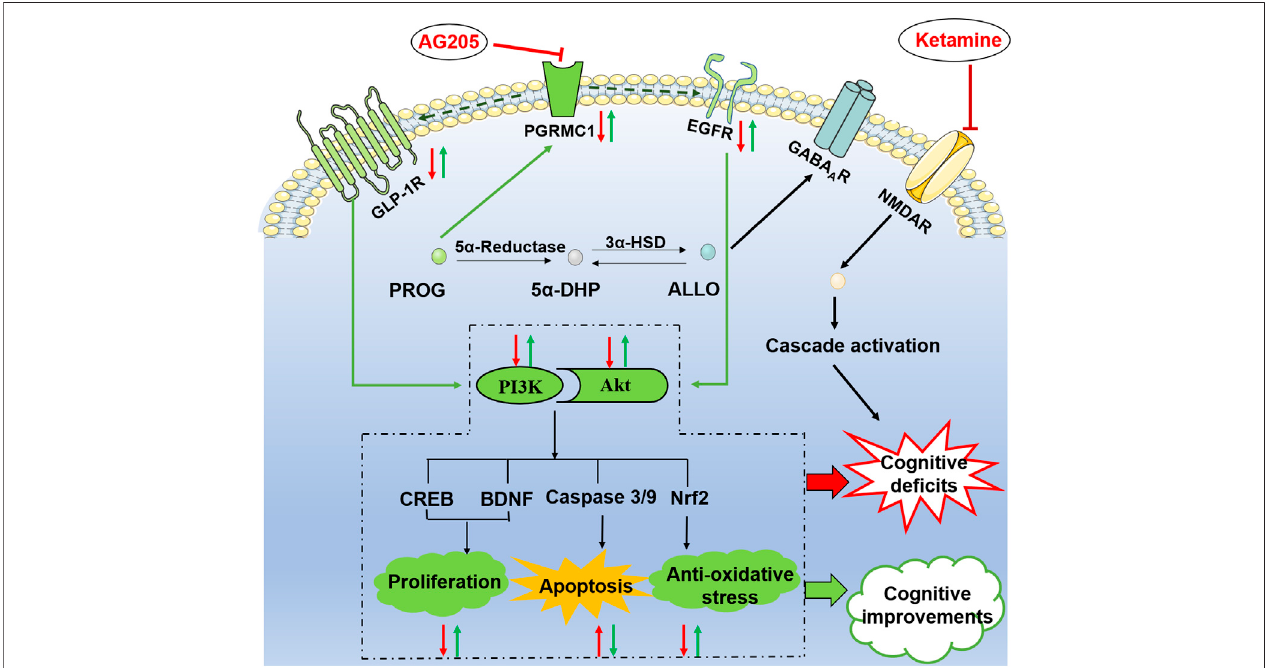
FIGURE 6 | Illustrative model of the mechanism underlying the neuroprotective effects of PROG and ALLO against ketamine-induced cognitive de fi cits. Under certain conditions, the PI3K/Akt pathway can be activated to exert its neuroprotective function by phosphorylating a battery of protein substrates, including Nuclear factor erythroid-2-relatedfactor 2(Nrf2), caspase-3/9,cAMPresponse element-binding protein (CREB) and brain-derived neurotrophicfactor (BDNF). Furthermore, the PI3K/Aktpathway isaputativedownstreamsignalingpathway regulatedbyEGFR andGLP-1Rtoelicitmultiple biologicalresponses, especiallycognitive function. Intriguingly, PGRMC1 co-precipitates and co-localizes with EGFR in cytoplasmic vesicles in cells and also serves as a novel component of the liganded GLP-1R complex. In the present study, the therapeutic effect of PROG or ALLO at least in part rely on the activation of PGRMC1/EGFR/GLP-1R/PI3K/Akt pathway in the brain. Moreover, the PRGMC1-speci fi c inhibitor AG205 signi fi cantly antagonized the therapeutic effects of PROG in the MWM task and downregulated the PGRMC1/EGFR/ GLP-1R pathway, which supports a role for PGRMC1 in the functional regulation of EGFR and GLP-1R, as well as their relation to neuroprotective